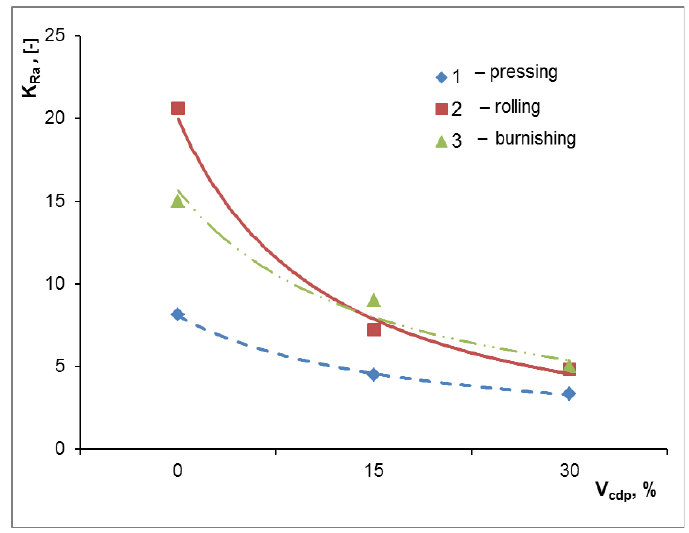
Figure 7. The impact of volume fraction ceramic dispersed phase V cdp in obtained composite coat- ings on surface roughness reduction ratio after plastic working, 1 — pressing, 2 — rolling, 3 — burnishing.